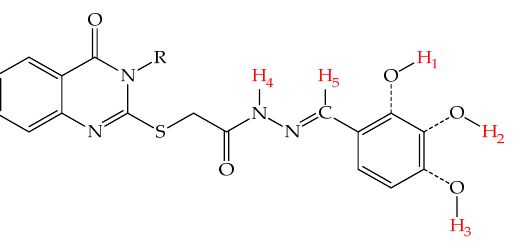
Figure 3. General structure representing the possible sites of molecules 5a – l to release hydrogen atoms numbered H 1 –H 5.